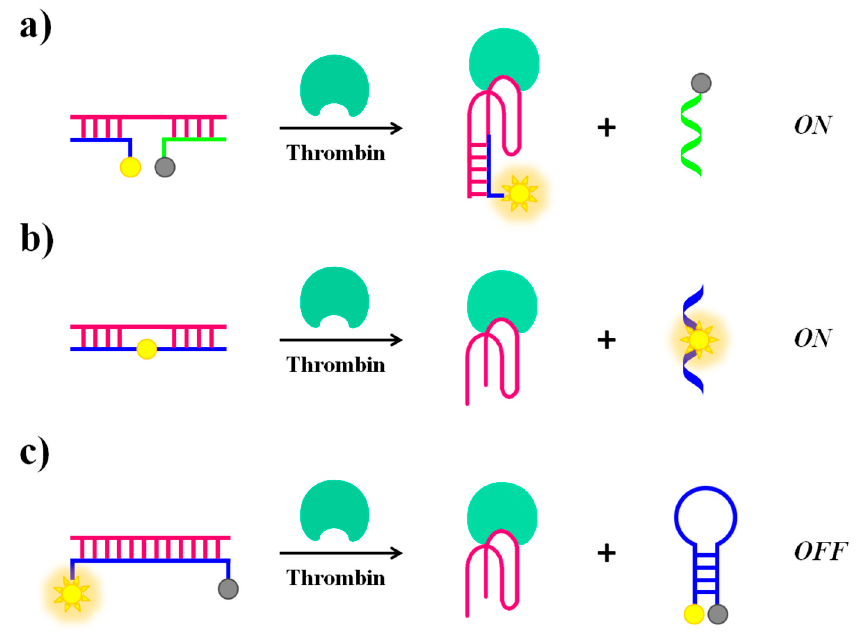
Figure 8. Schematic representation of molecular beacons strategies based on “structure switch signalling aptamer” from a duplex structure to a G4 induced by addition of thrombin causing “turn on” ( a , b ) or “turn-off” ( c ) of the fluorescence signal.